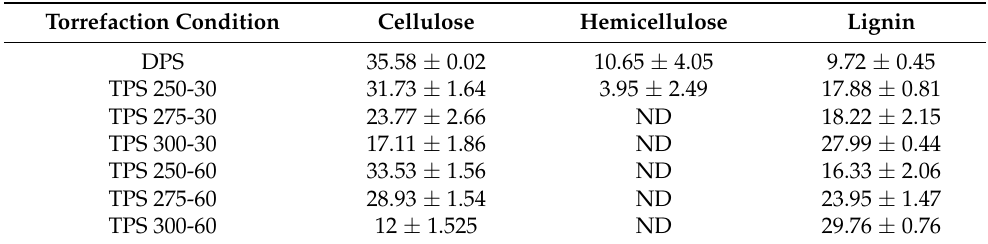
Table 6. Chemical composition of dried and torrefied pulp industry sludge in terms of major biomass